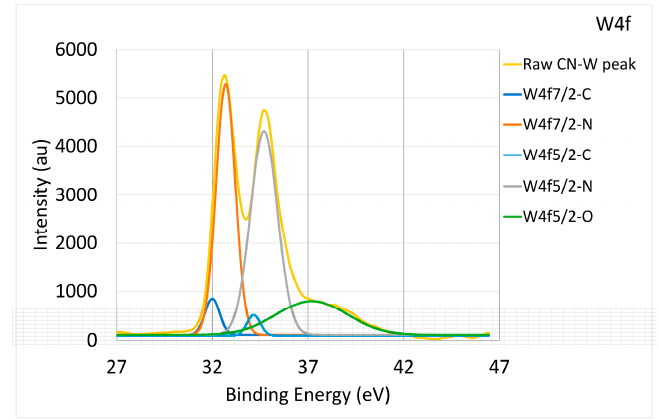
Figure 3. Bonding energy of CNx-Ti coating characterized by XPS: ( a ) C1s XPS raw and deconvoluted spectra; ( b ) N1s XPS raw and the deconvoluted spectra; and ( c ) Ti2p raw and deconvoluted spectra.